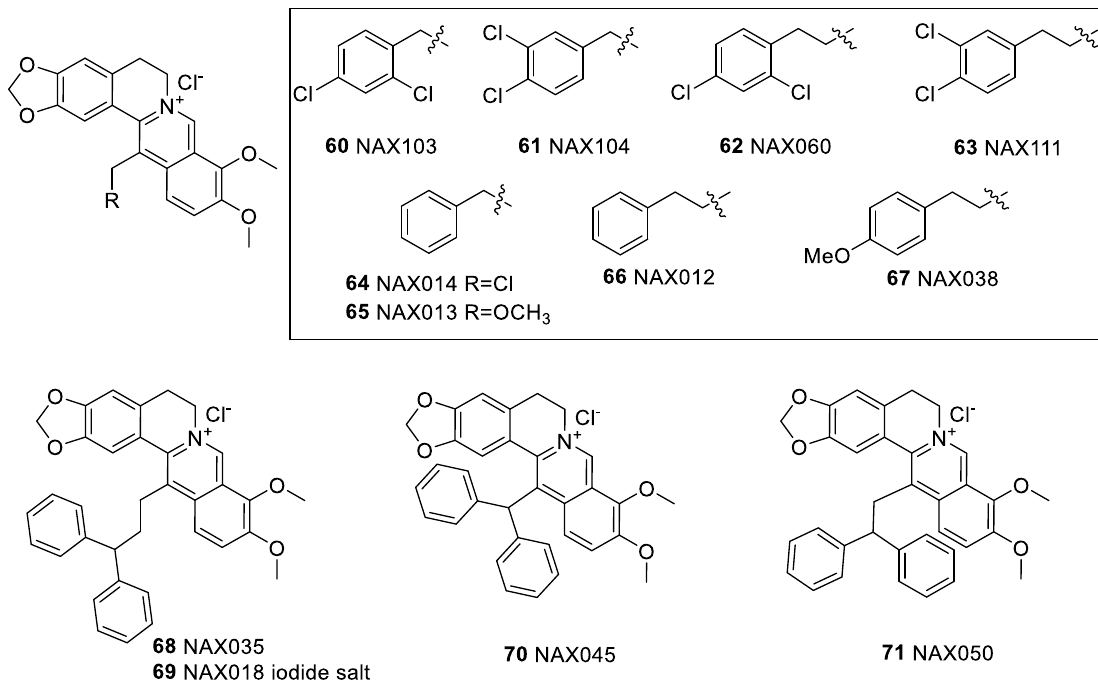
Figure 8. Berberine-13- C -phenyl derivatives.